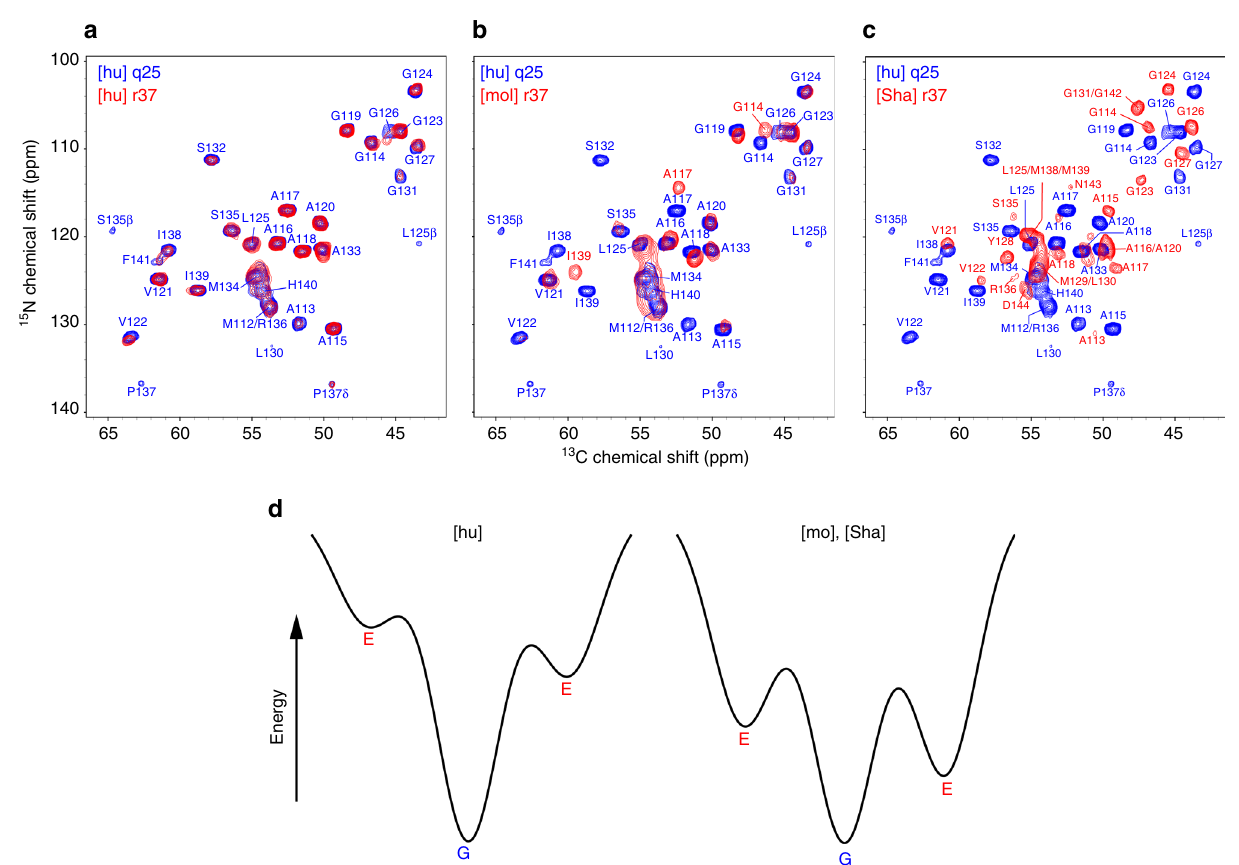
Fig. 5 15 N – 13 C α solid-state NMR spectra of PrP23-144 fi brils at 37 °C with rotation and energy landscape diagrams for amyloid assembly. a – c Assigned two-dimensional 15 N – 13 C α fi ngerprint solid-state NMR spectra of a [hu], b [mo], and c [Sha] amyloid fi brils generated at 37 °C with continuous sample rotation at 8 rpm ( red contours , labeled in the insets as [hu] r37, [mo] r37, and [Sha] r37). Overlaid in each panel is the spectrum of huPrP23-144 fi brils generated at 25 °C under quiescent conditions (q25, blue contours ). d Schematic energy landscape diagrams associated with [hu], [mo], and [Sha] amyloid fi bril formation, with the thermodynamically most stable “ ground state ” and potential alternate “ excited state ” amyloid folds denoted as “ G ” and “ E ” , respectively. The ground state in the energy landscape for each protein in the amyloid state is designated as the structure adopted under quiescent conditions at 25 °C (q25), as under these conditions each of these proteins adopts a unique (presumably lowest free energy) fold which can also be populated for some of the samples even under non-quiescent conditions. Under the speci fi c non-quiescent conditions tested in this study involving rotation at 37 °C (r37), the fold of [hu] amyloid remains unchanged, whereas the mo and Sha proteins are able to adopt alternate amyloid structures through a combination of thermodynamic and kinetic factors. Additional details are provided in the